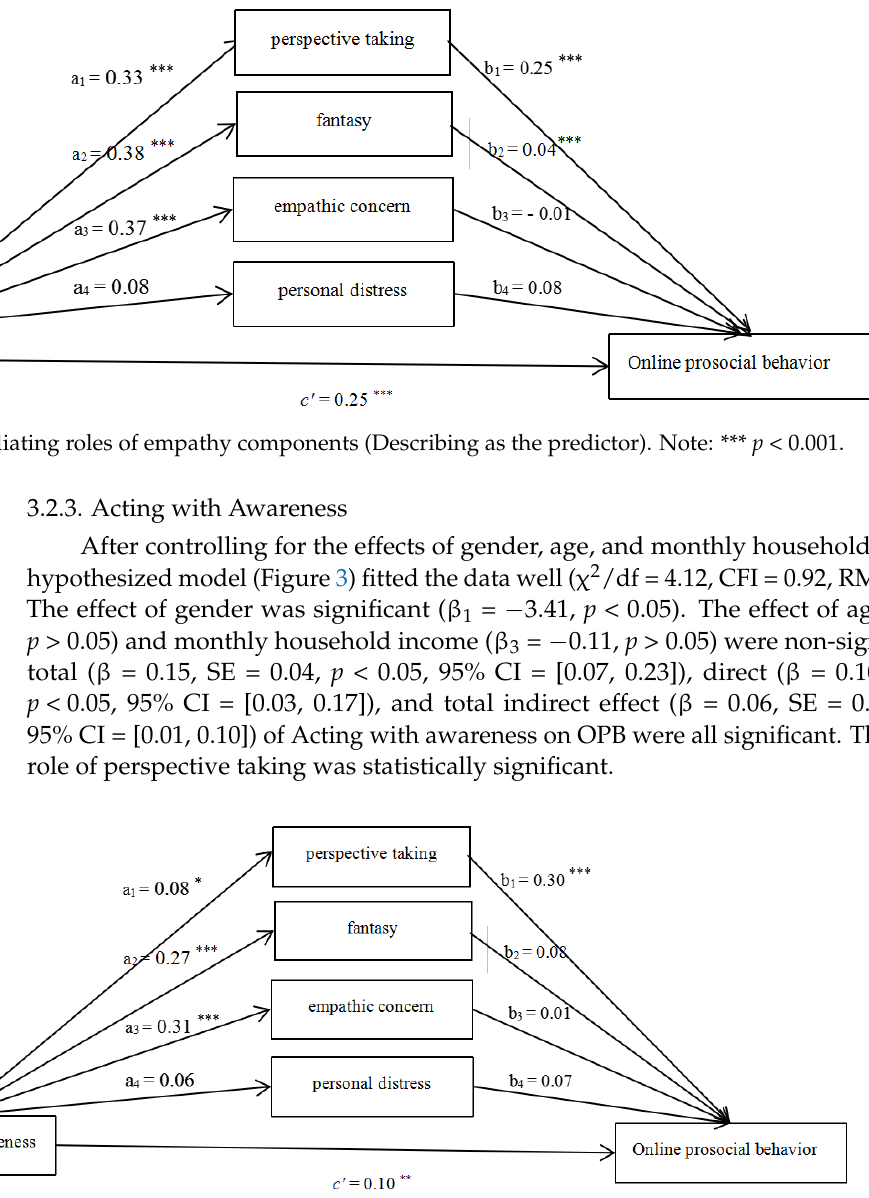
Figure 3. Mediating roles of empathy components (Acting with awareness as the predictor). Note: * p < 0.05, ** p < 0.01, *** p <